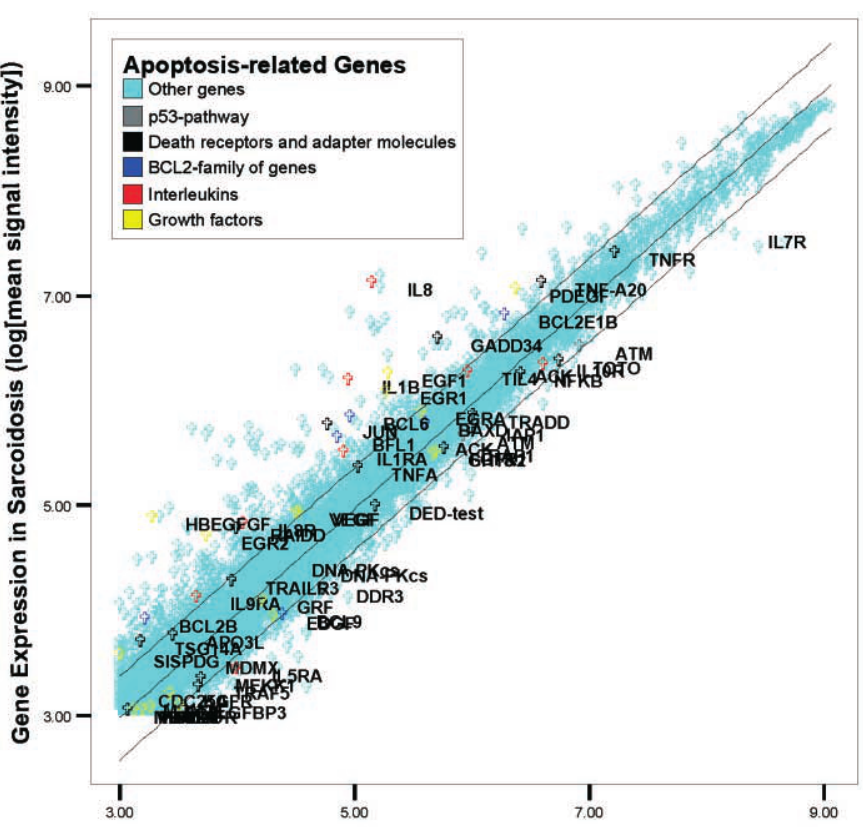
Scanned pseudo-colour image of a hybridised human HUG95A GeneChip ® expression array with enlarged probe set of a gene as an insert top right. This specific microarray shown con- tains probe sets interrogating approximately 12,000 full-length human genes and some EST clusters from the UniGene database (Build 95). Using reverse transcriptase messenger RNA (mRNA) is by copied into a cDNA population reflecting the relative abundance of the individ- ual mRNAs. In a next step labelled cRNA is generated by in vitro transcription, hybridised to the GeneChip ® expression array, stained with a fluorecent dye and analysed using a laser scanner. The intensity of the hybridisation signal for a given gene is a result of its relative abundance in the mRNA-derived target cRNA. The method is described as providing excellent specificity and reproducibility. Messenger RNA species comprising 1:10,000-100,000 of the mass of the target mRNA, which corresponds to approximately 1 transcript per 100,000, can readily be detected.